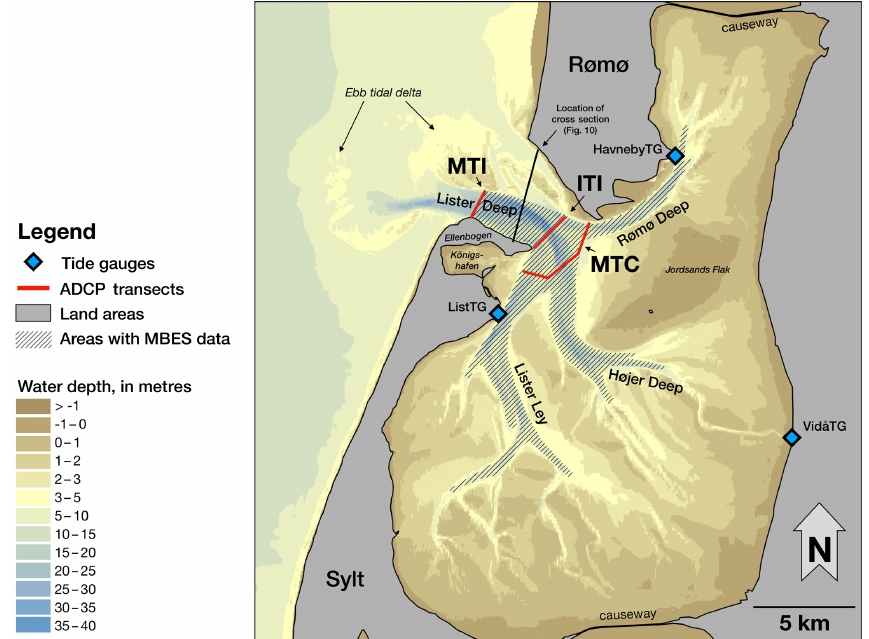
Figure 1. The bathymetry of the considered domain. The red lines indicate acoustic Doppler current profiler (ADCP) transects, the blue rhombuses show positions of the tide gauges. The hatching represents the zone with the recent multibeam echo sounder (MBES)